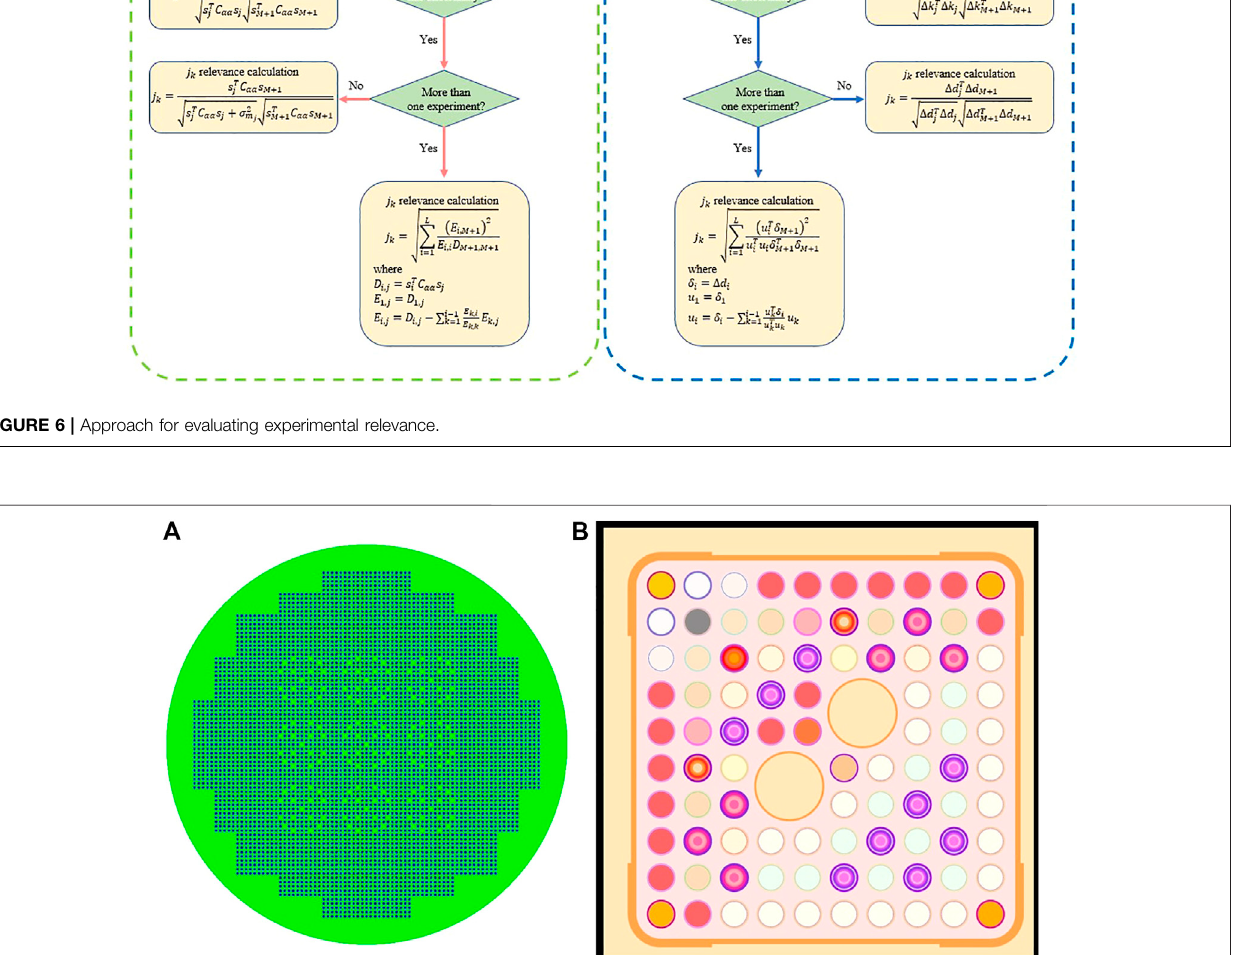
Frontiers in Energy Research |